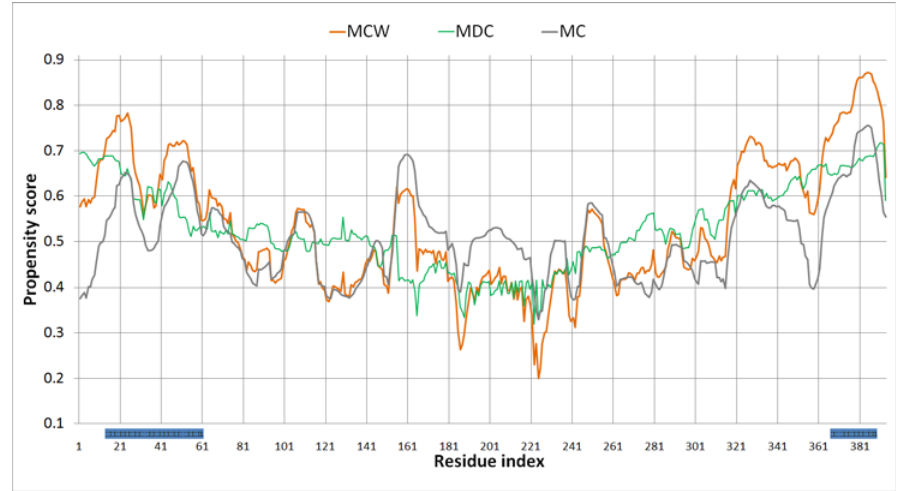
Fig 5. MoRF CHiBi_Web Propensity scores for the protein p53. Propensity scores for the protein p53 by MoRF CHiBi_Web (MCW) in orange, MoRF CHiBi (MC) in gray and MoRF DC (MDC) in green. The 2 verified MoRF sections in our EXP53 test set are marked in blue below the chart.